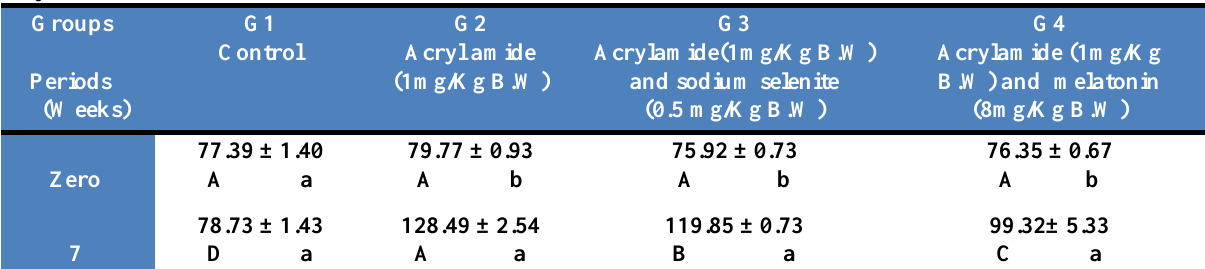
Table, 2: Effect of sodium selenite and melatonin on serum total cholesterol (TC) concentration (mg/dl) in acrylamide treated rats.